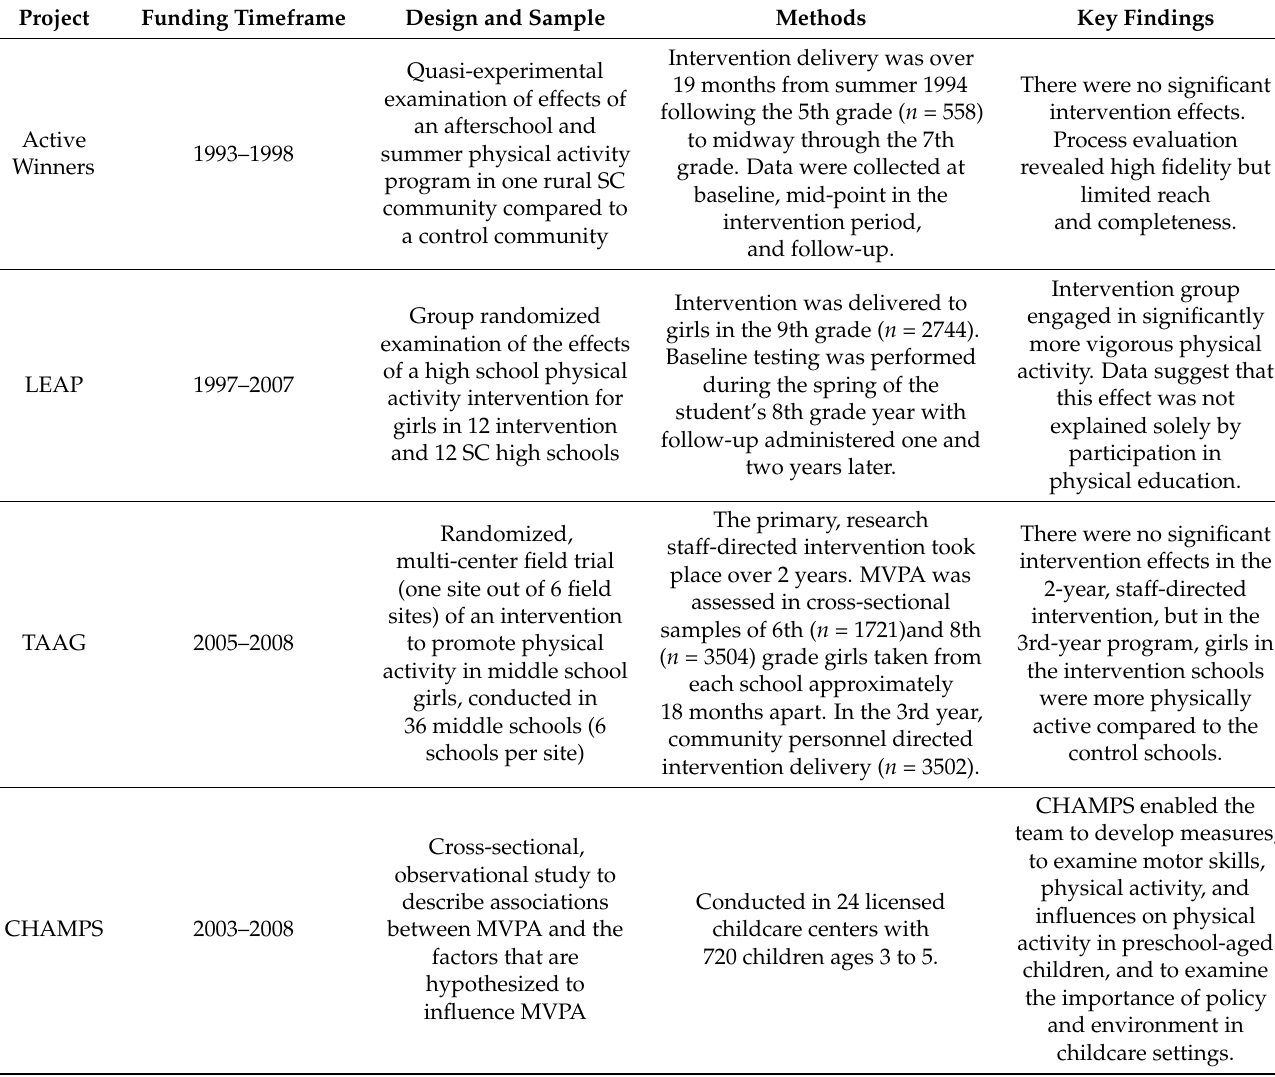
Table 1. Overview of Selected CPARG Research Projects Featured in This